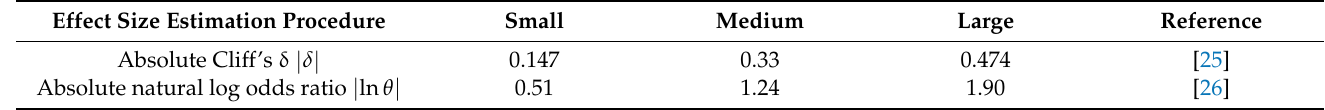
Table 4. The absolute effect size